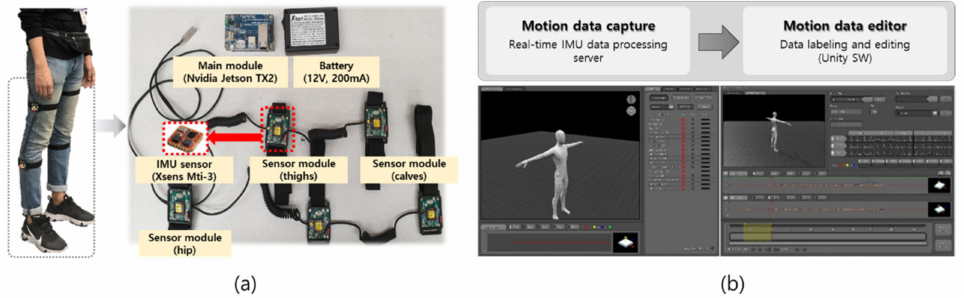
Figure 3. Falls data acquisition system; ( a ) hardware and ( b ) software configurations of the